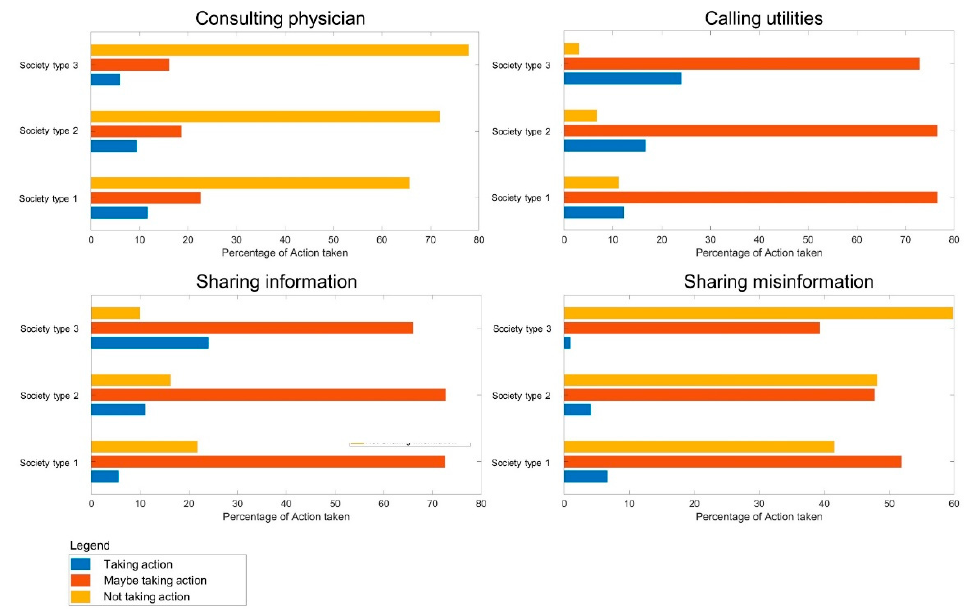
Figure 10. Percentages of the actions taken, maybe taken or not taken by the consumer agents for each society type for scenario two.